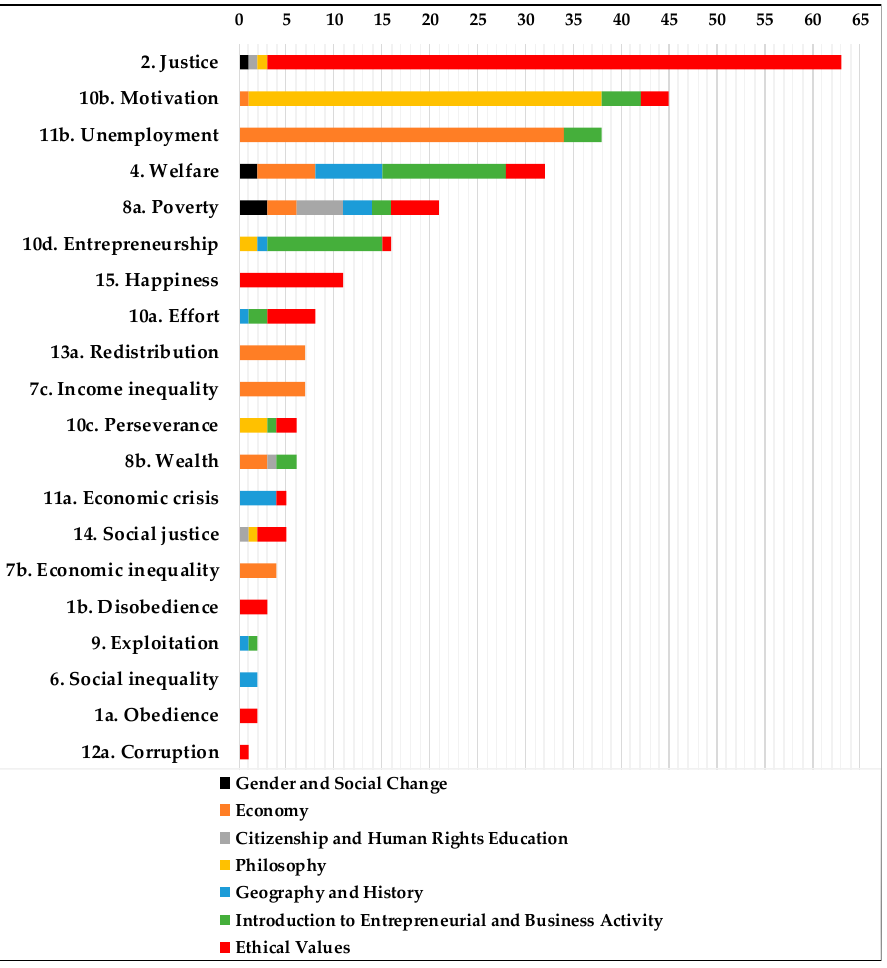
Figure 2. Number of keywords by subject areas.